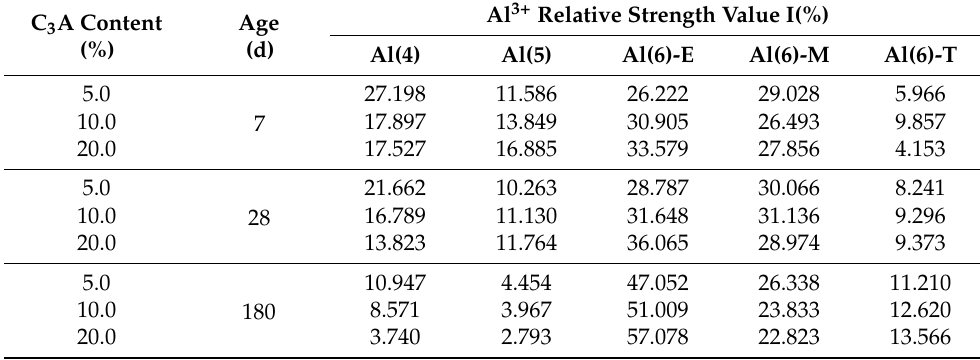
Table 4. Deconvolution Results of 27 Al NMR